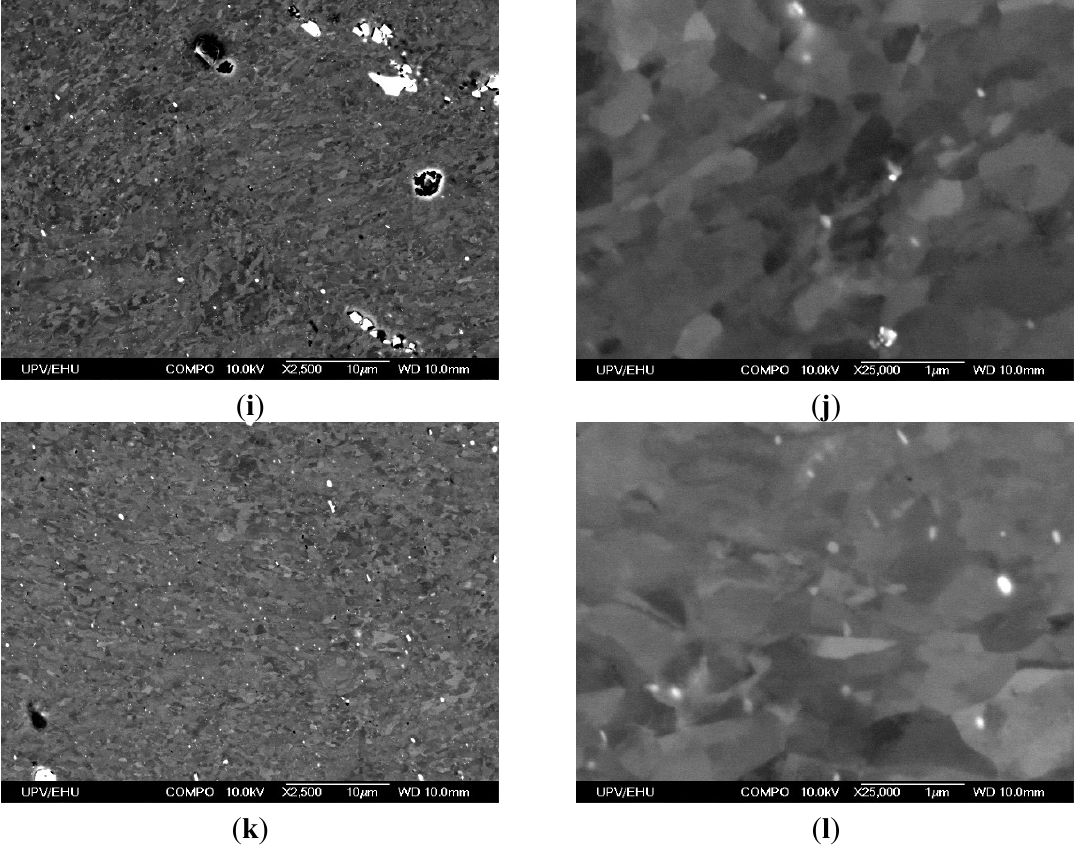
Figure 13. SEM micrographs of the connecting rods forged at the optimum